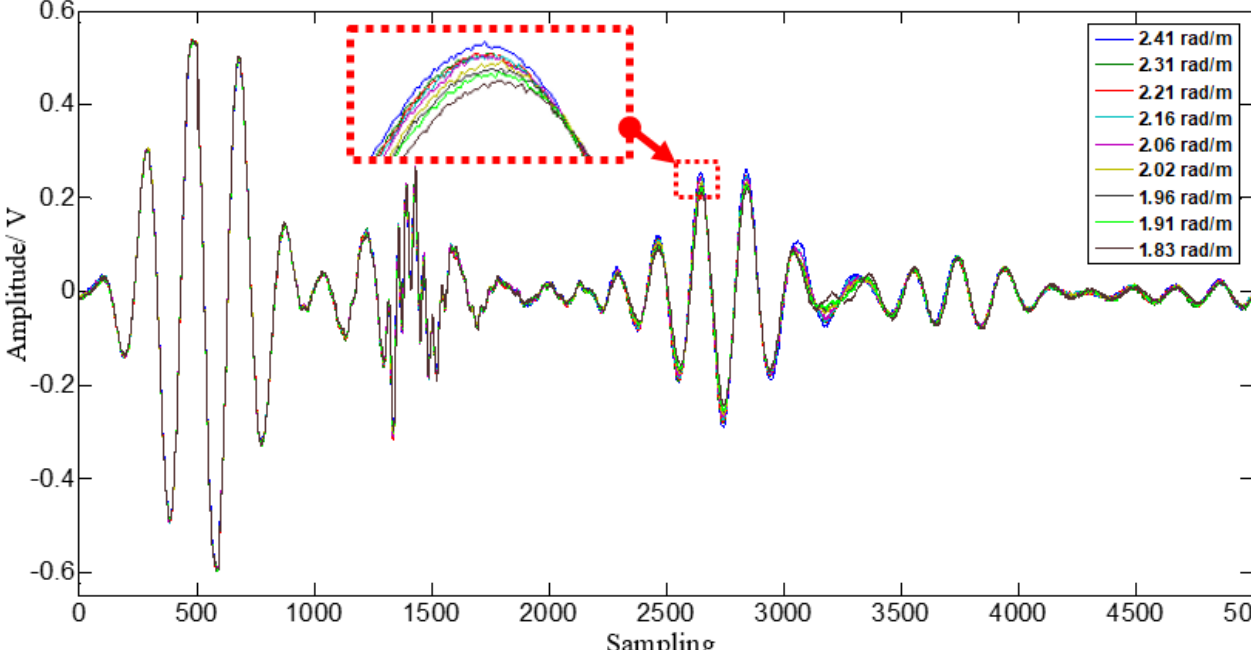
Figure 10. Comparison of PZT 1 sensor signals with different loading conditions.